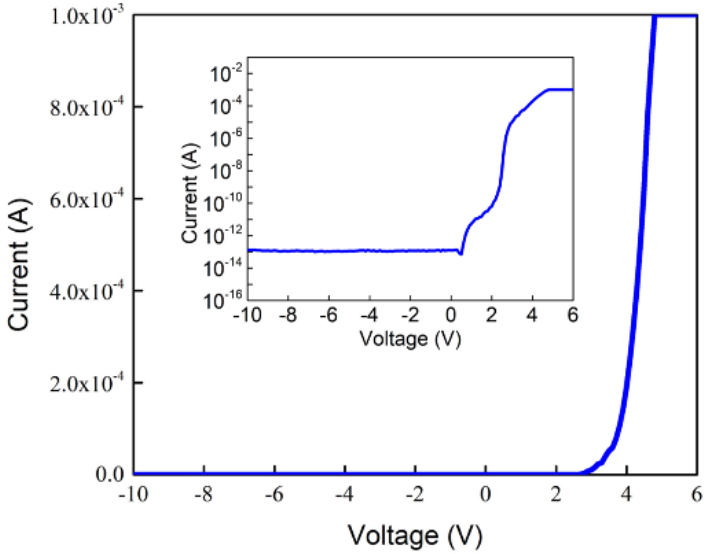
Figure 4. Linear current-voltage (I − V) characteristics for a single pixel with a 5 μm size for the 1920 × 1080 blue MicroLEDs. Inset: logarithm current versus voltage plot for a single pixel of blue MicroLEDs.